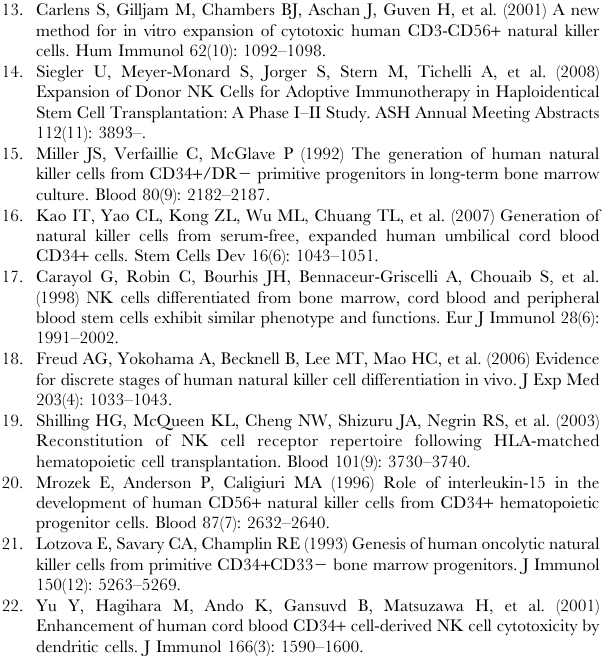
Figure S2 Phenotypical profile of ex vivo -generated NK cells using Method II with GBGM. (a) Flow cytometric analysis of a second NK cell product generated from CD34 + UCB progenitor cells. Cells at 5 weeks of culture were analyzed for expression of CD56, CD3, CD94 and CD16. (b) Expression of a repertoire of receptors important for regulating NK cell activity, including C- type lectin receptors, natural cytotoxicity receptors and cytokine receptors. Histograms show expression of the antigen of interest (black histogram) compared to the specific isotype control (grey histogram). (c) Acquisition of KIR + NK cell subsets during ex vivo NK cell generation from expanded CD34 + UCB cells. KIR expression was determined at week 4 and 5 during the differentiation step by FCM. Figure S3 Responsiveness of ex vivo -generated KIR + NK cells generated using Method II with GBGM to MHC class I-deficient target cells. Ex vivo -generated NK cells were incubated alone, or 18 hours with MHC class I-negative K562 or MHC class I- expressing KG1a cells at an E:T ratio of 1:1. Cells were then stained for CD56, CD3, KIR, and the degranulation antigen CD107a. Shown are the degranulation of total CD56 + CD3 2 NK cells and KIR2DL2/DL3 + NK cell subset expanded for 5 weeks from CD34 + UCB cells. Density plots are gated on CD56 + CD3 2 NK cells and the histogram plots show the CD107a degranulation of the KIR2DL2/DL3 + NK cells. Figure S4 Responsiveness of ex vivo -generated KIR + NK cells generated by Method II to target cells expressing different KIR ligands. Activity of UCB-derived NK cells derived from two different donors were tested in a 2 hour CD107a degranulation assay against K562 cells transfected with empty vector (EV), HLA- Cw3 cDNA, HLA-Cw4 cDNA or both. Figure S5 Functional activity of ex vivo -generated CD56 + NK cells using Method II. (a) Specific cytotoxicity of two CD56 +